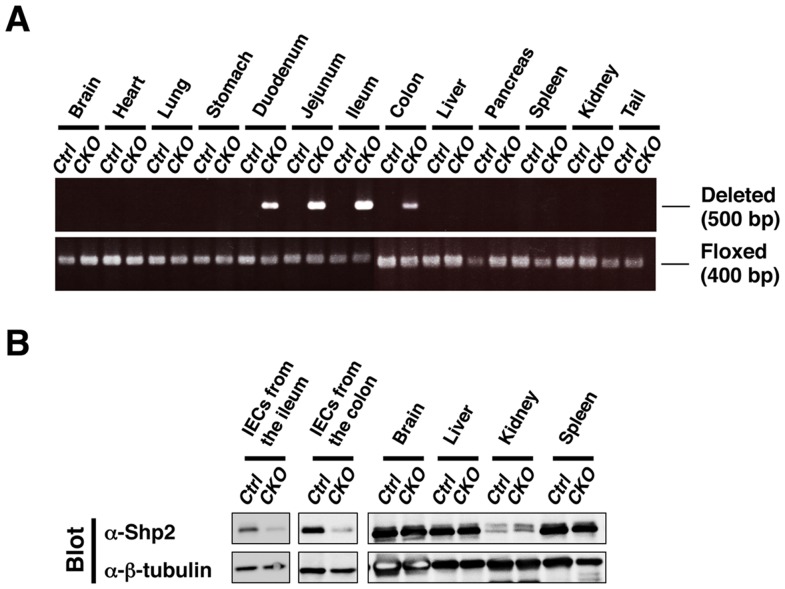
Generation of IEC-specific Shp2 CKO mice.
A: Genomic DNA extracted from the indicated organs of adult control (Ctrl) or Shp2 CKO (CKO) mice was subjected to PCR analysis with primers specific for deleted or floxed alleles of Ptpn11. Data are representative of three separate experiments. B: Lysates of IECs (from the ileum or colon) and the indicated organs from control or Shp2 CKO mice were subjected to immunoblot analysis with antibodies to (α-) both Shp2 and β-tubulin (loading control). Data are representative of three (IECs) or two (indicated organs) separate experiments.